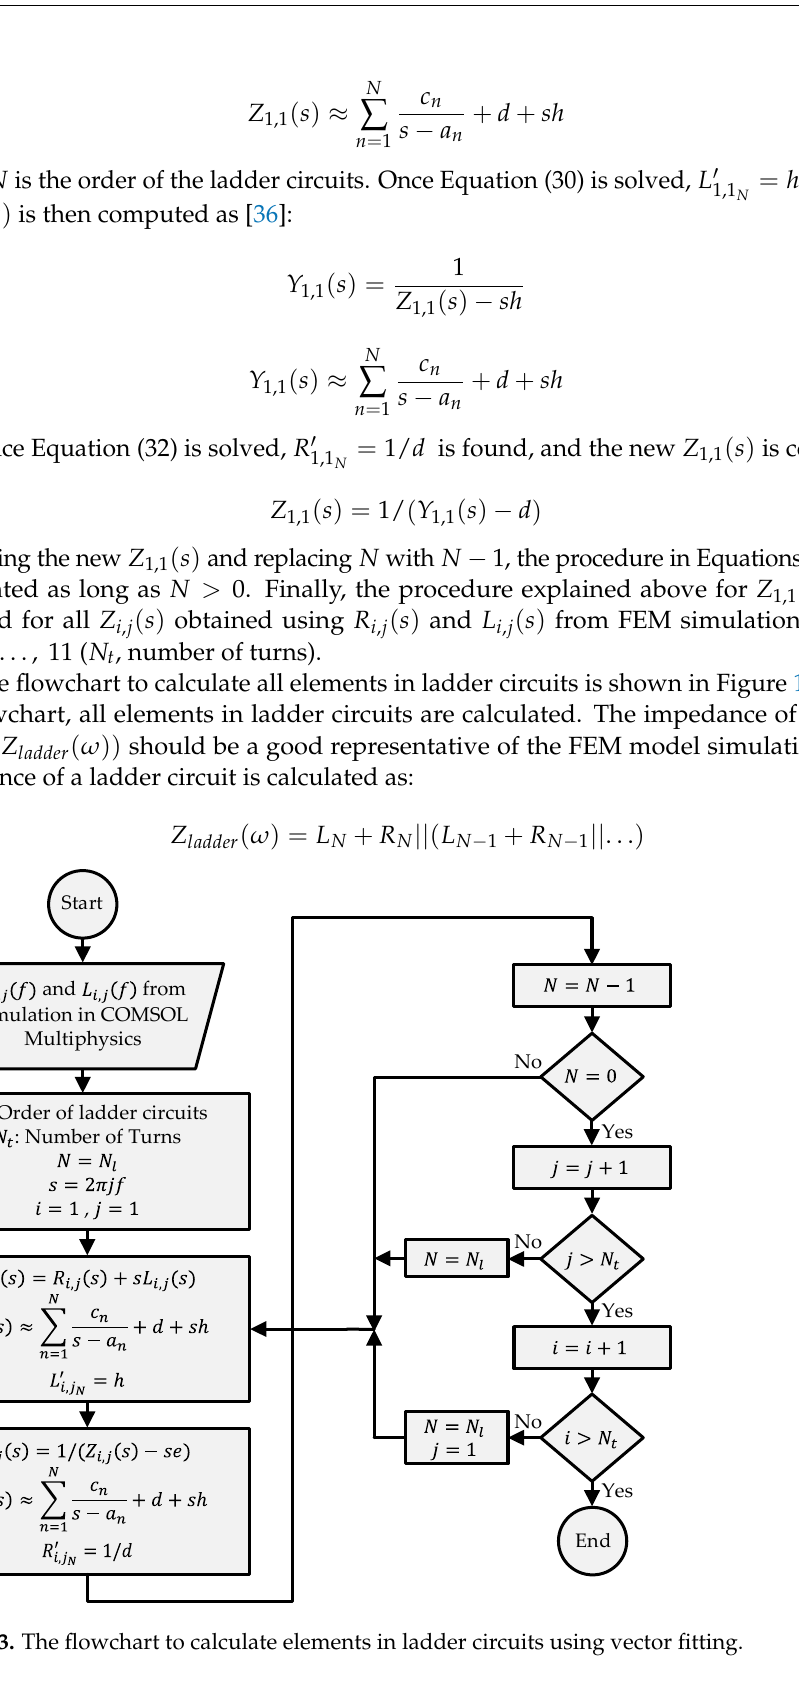
Figure 14. Comparison of 𝑅 1,1 (𝑓) and 𝐿 1,1 (𝑓) resulting from FEM simulations and 𝑅 1,1 (𝑓) and 𝐿 1,1 (𝑓) resulting from ladder circuits with different layers calculated by vector fitting in MATLAB.